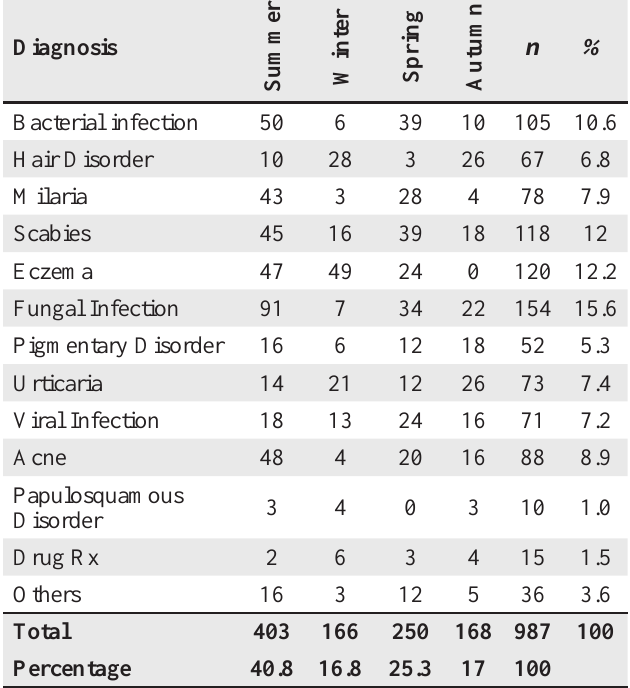
Table 1 : Seasonal trend of different dematoses